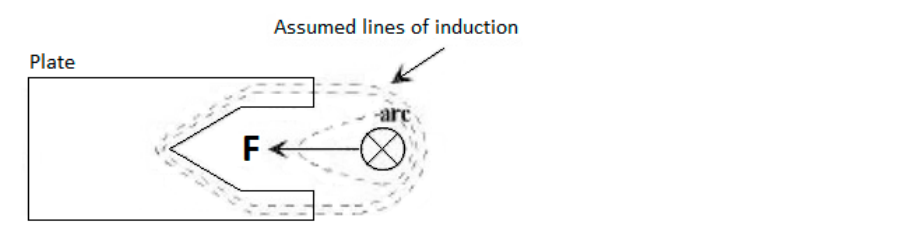
Figure 3. Principle of electrodynamic forces acting on the electric arc in arc chambers [2].